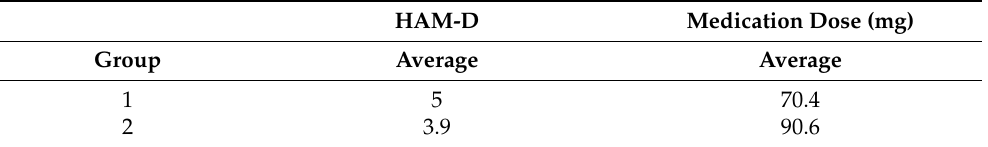
Table 6. The average of HAM-D and medication dose. The medication dose values are converted to the equivalent of antidepressant imipramine. These properties also show no significant difference. HAM-D